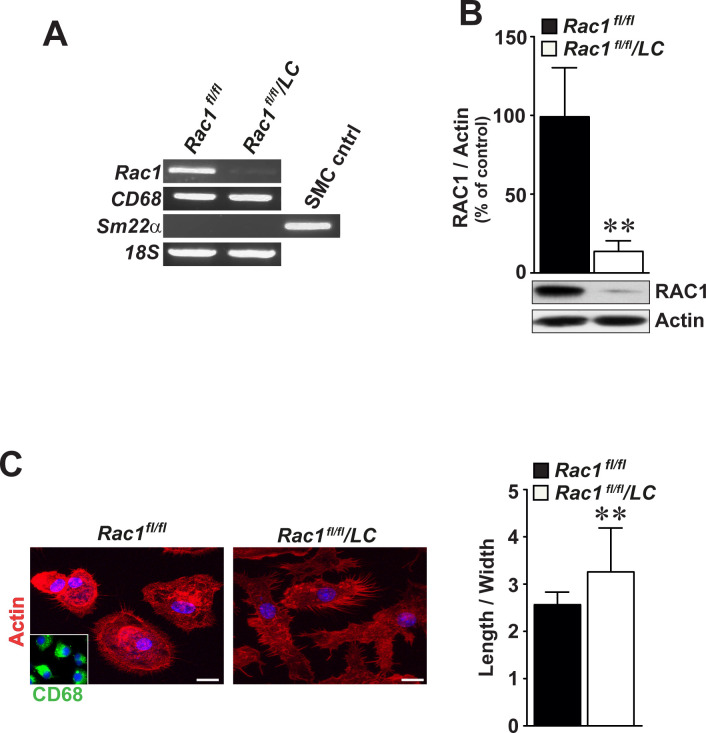
Bone marrow-derived macrophages deficient for RAC1 display longer cell shape.(A) RT-PCR analysis of Rac1, CD68, and Sm22α in cultured BMMs by gel electrophoresis. 18S mRNA serves as an internal loading control. (B) Immunoblot analysis of RAC1 in Rac1fl/fl and Rac1fl/fl/LC BMMs. Actin was included as an internal loading control. (C) Morphological shape of Rac1fl/fl and Rac1fl/fl/LC BMMs as detected by actin immunofluorescence staining (left images). Inset demonstrates CD68-positivity in BMMs. Scale bars represent 10 μm. Quantification of ratios of macrophage cell elongation (right graphs). Mean ± SEM values of percentage or fold changes in at least triplicated data. Student’s t-test was used. **p<0.01.